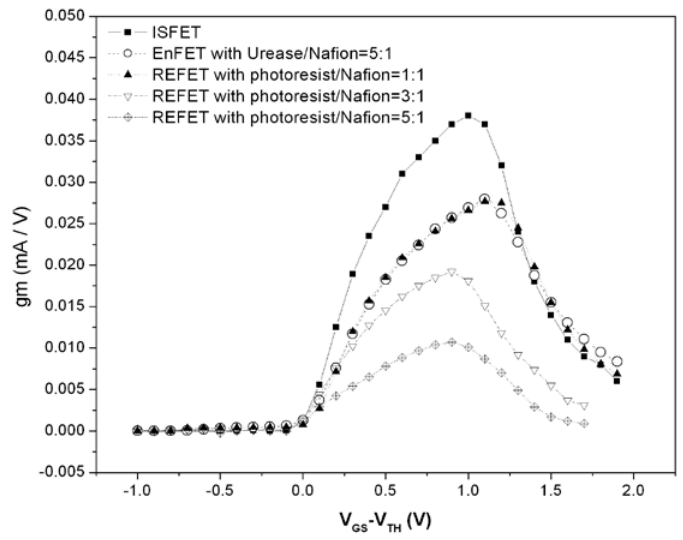
Figure 8. The g curves of ISFET, EnFET and m